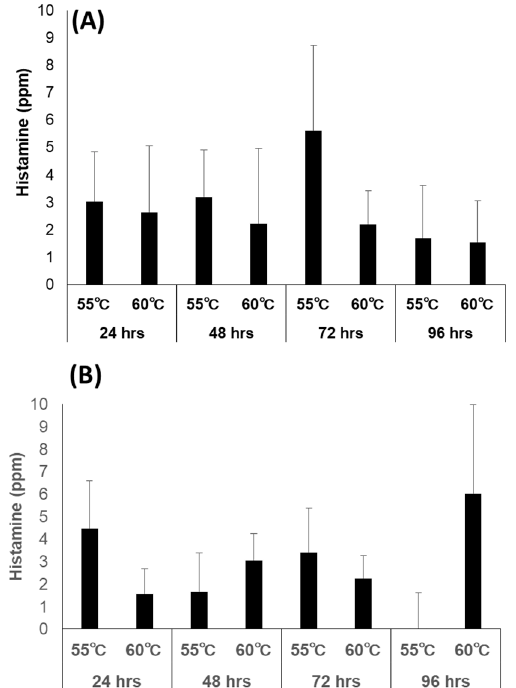
Figure 9. Histamine concentration of the mixtures of masu salmon reacted at 55 °C ( A ) and 60 °C ( B ) for 96 h. Values represent mean ( n = 3). An asterisk shows significant different ( p < 0.05).